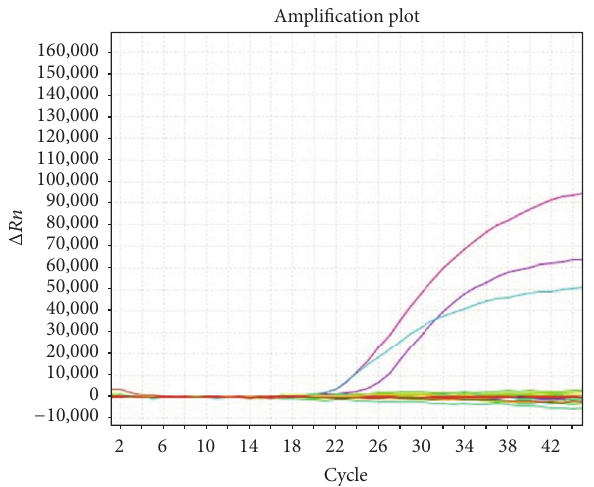
Figure 4: Species-specificity assay for raccoon dog identification. Raccoon dog samples gave positive results. No cross-reactivity with cattle, deer, dog, horse, pig, sheep, and rabbit was detected.